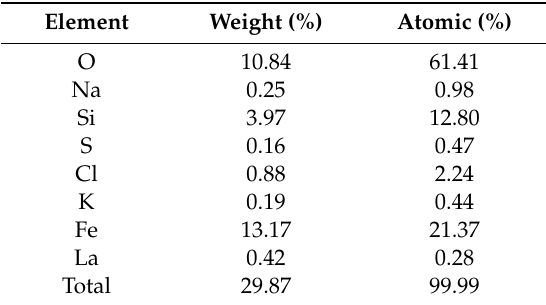
Table 5. Elemental analysis after Fe x O y NP loading.